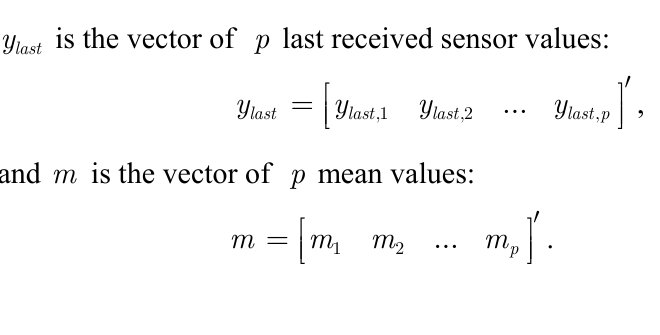
Figure 3. Structure of the modified Kalman filter